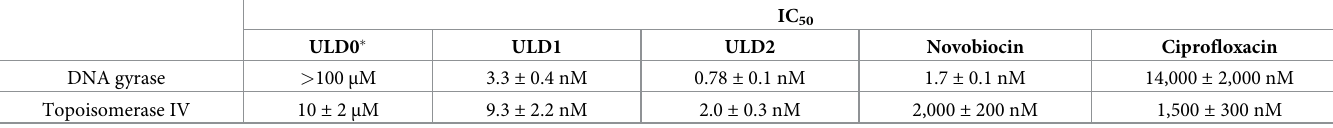
Table 1. In vitro inhibition of DNA gyrase and topoisomerase IV by ULD1 and